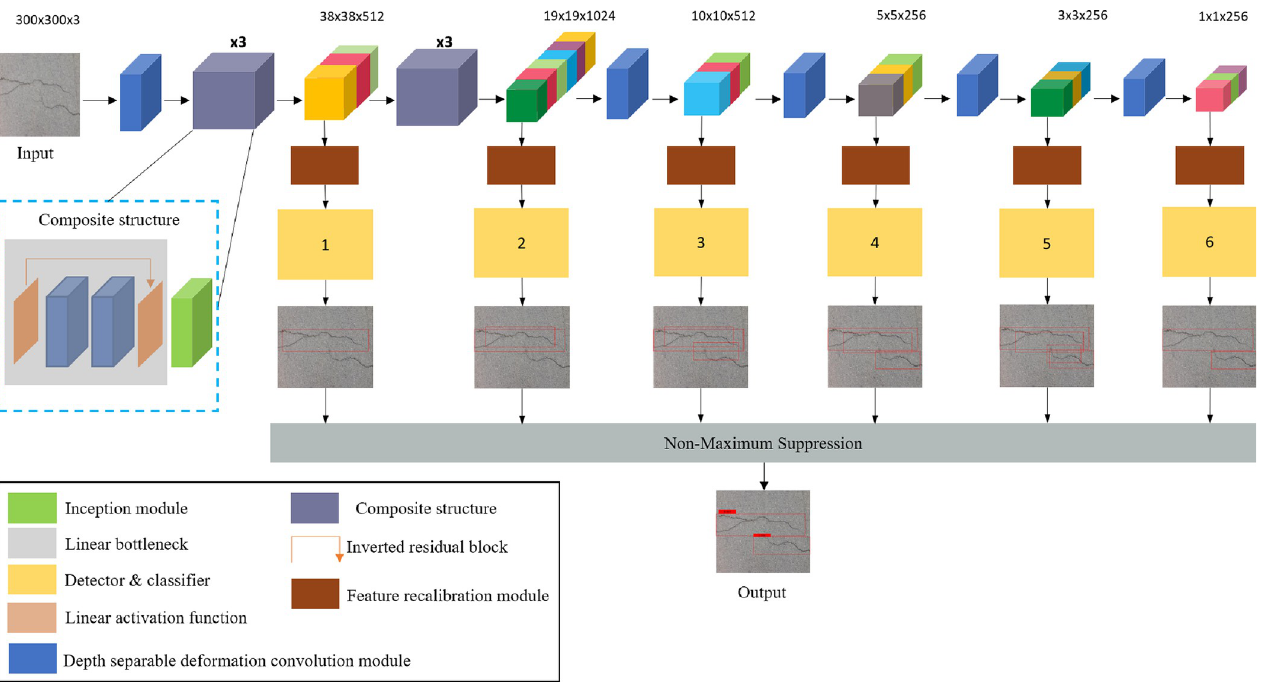
Fig 2. Structure of